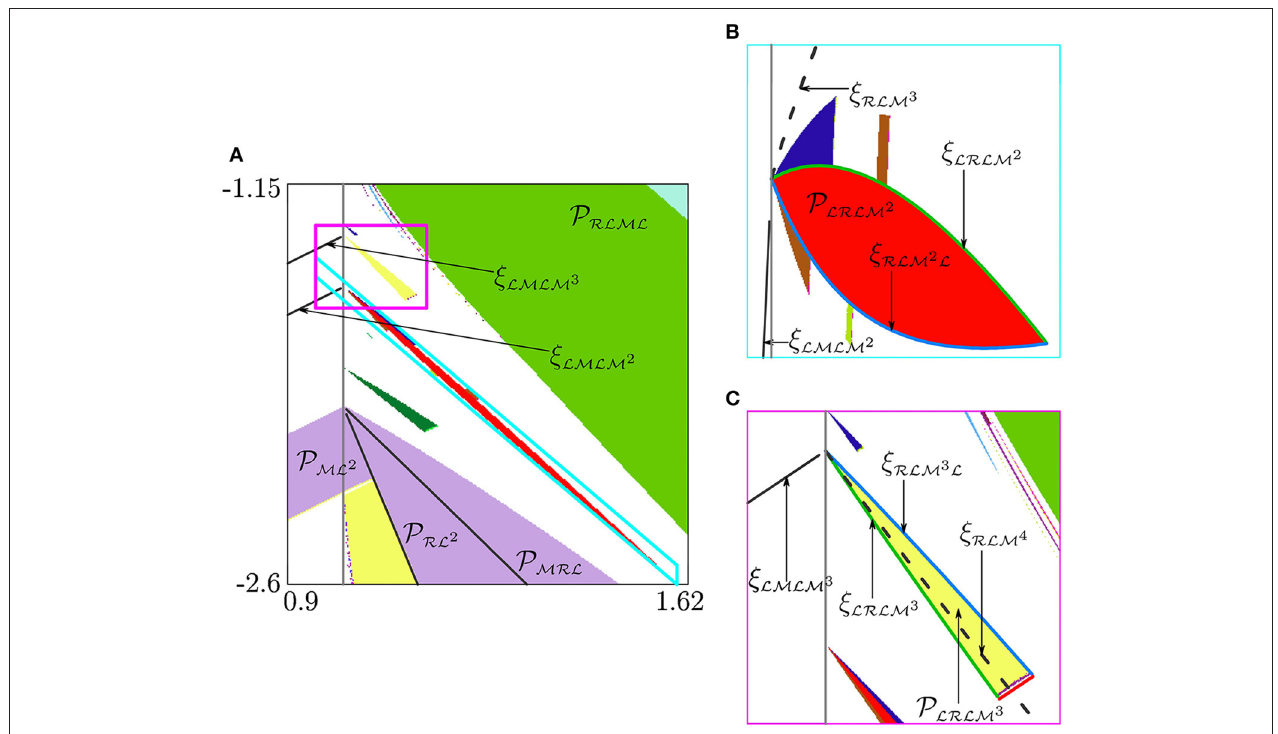
FIGURE 8 | Stabilization of U-sequence cycles. Panels (B,C) are the enlargements of the areas marked in (A) by blue and magenta lines, respectively. The parameters are a L = 0.57, a R = 0.2, d L = 0, d R = 1.